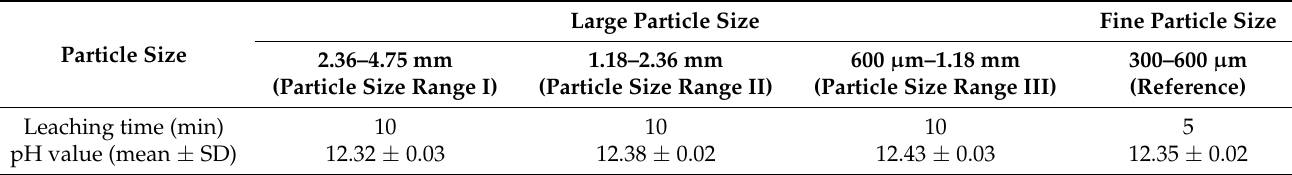
Table 5. Effect of leaching time for different large particle sizes on pH.